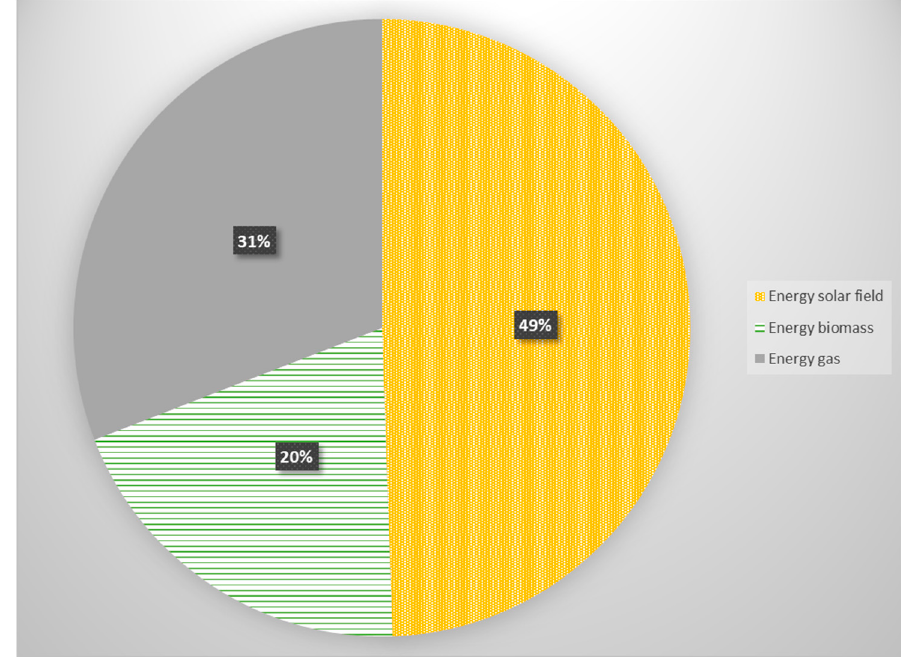
Figure 16. Distribution of energy supplied over the whole lifespan (connection 1).